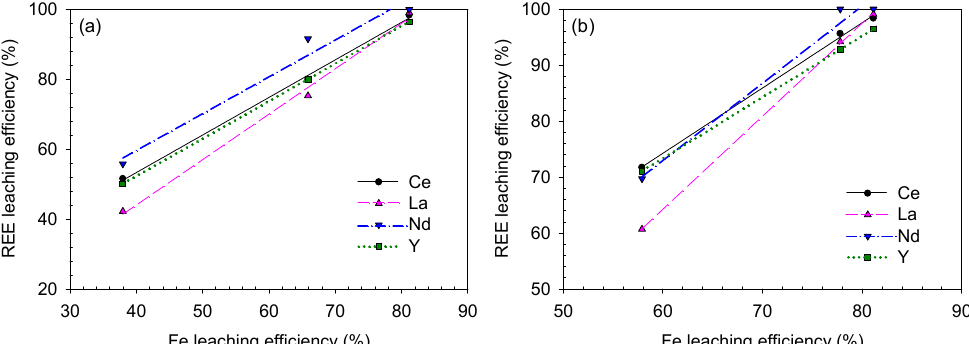
Figure 17. REE–Fe-leaching efficiency correlation for the sulfuric acid baking–water-leaching results based on ( a ) acid / solid ratio and ( b ) leaching temperature. Minerals 2020 , 10 , x FOR PEER REVIEW